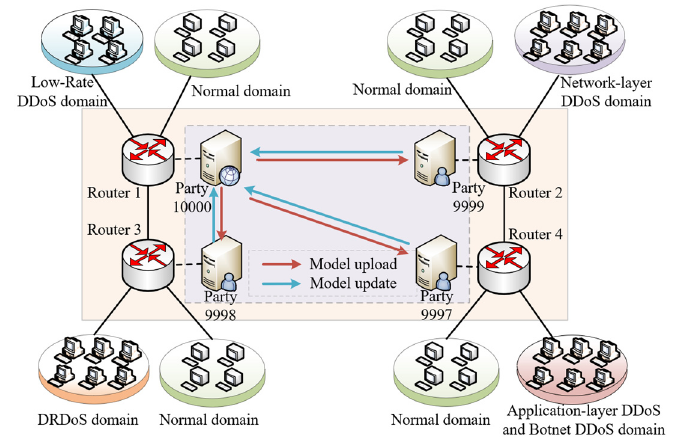
Figure 7. Experimental topology.